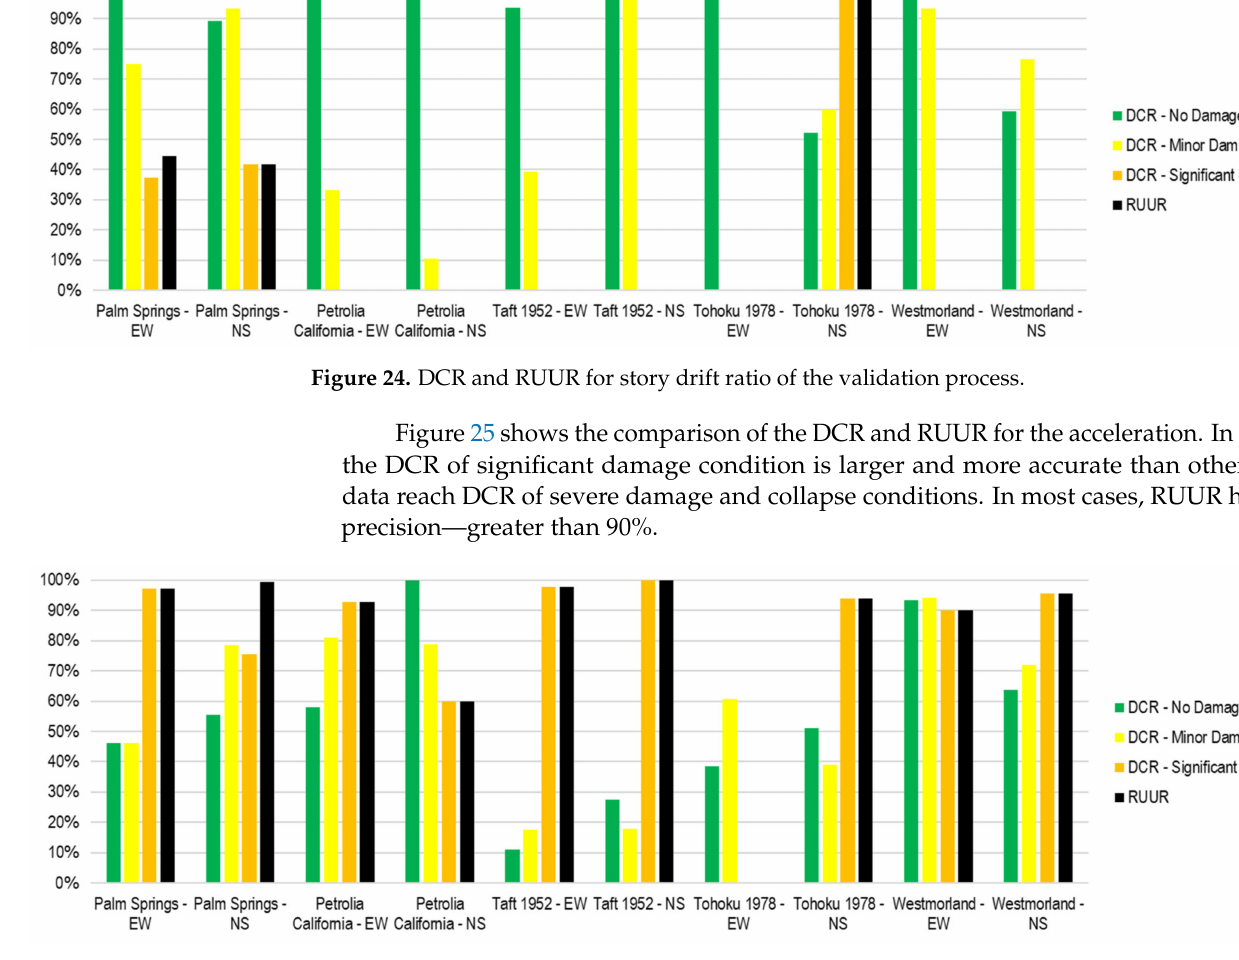
Figure 25. DCR and RUUR for the acceleration of the validation